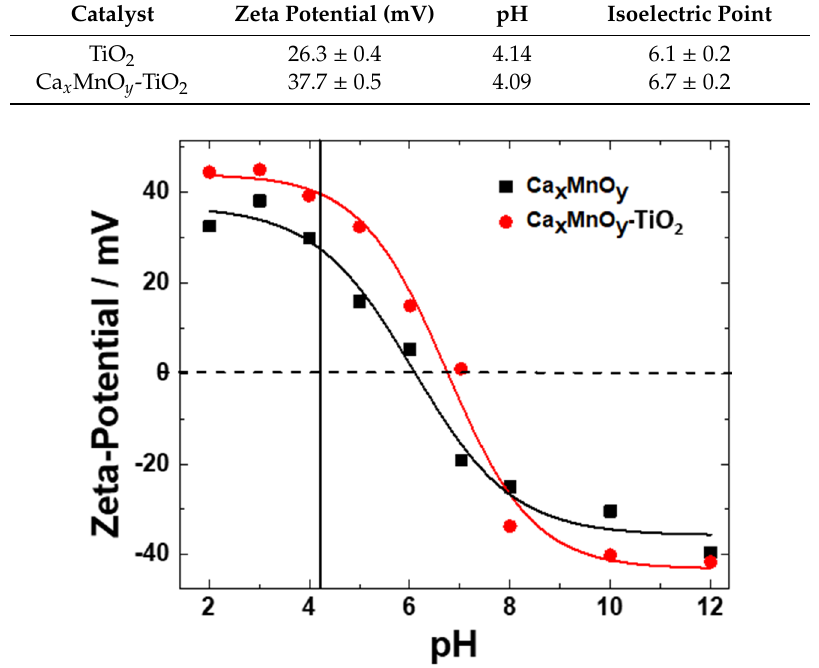
Table 1. The pH value, isoelectric point and zeta potential of pure TiO 2 and Ca x MnO y -TiO 2 . Catalyst